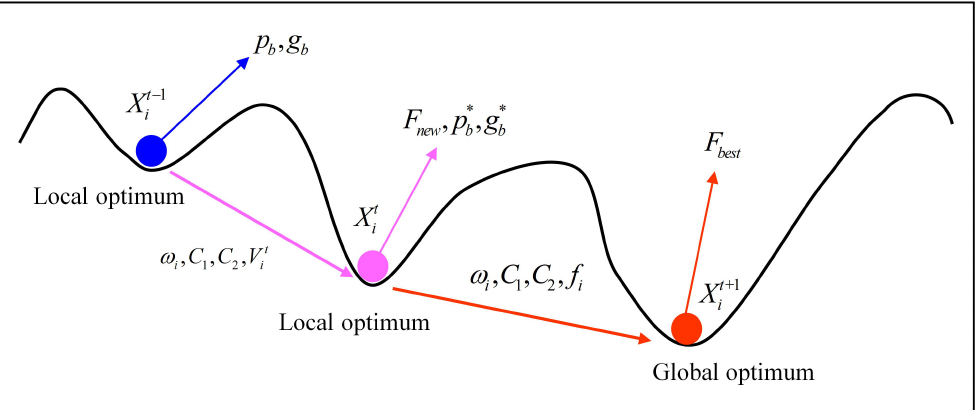
Figure 5. The optimization process of